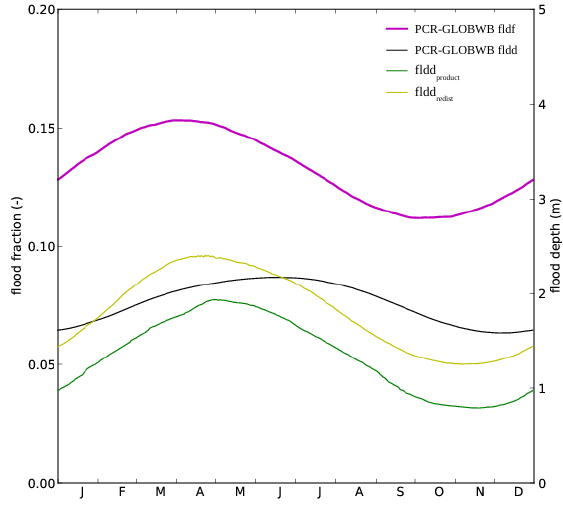
Fig. A2. Seasonal cycle of PCR-GLOBWB outputs and correspond- ing LPX inputs over the whole Amazon Basin. Floodplain frac- tion (magenta) and flood depth (black, green, yellow) are given. Note that fldd product and fldd redist corresponds to flood depth over a yearly constant floodplain fraction (fldf mean ) while PCR-GLOBWB fldd is given for a seasonal-variable floodplain